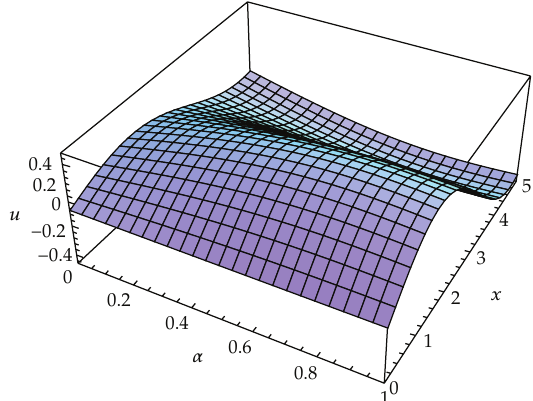
Figure 2: The surface of third-order approximate solution u (cid:2) x,t (cid:3) of (cid:2) 3.8 (cid:3) and (cid:2) 3.9 (cid:3) when t (cid:9) 0 .